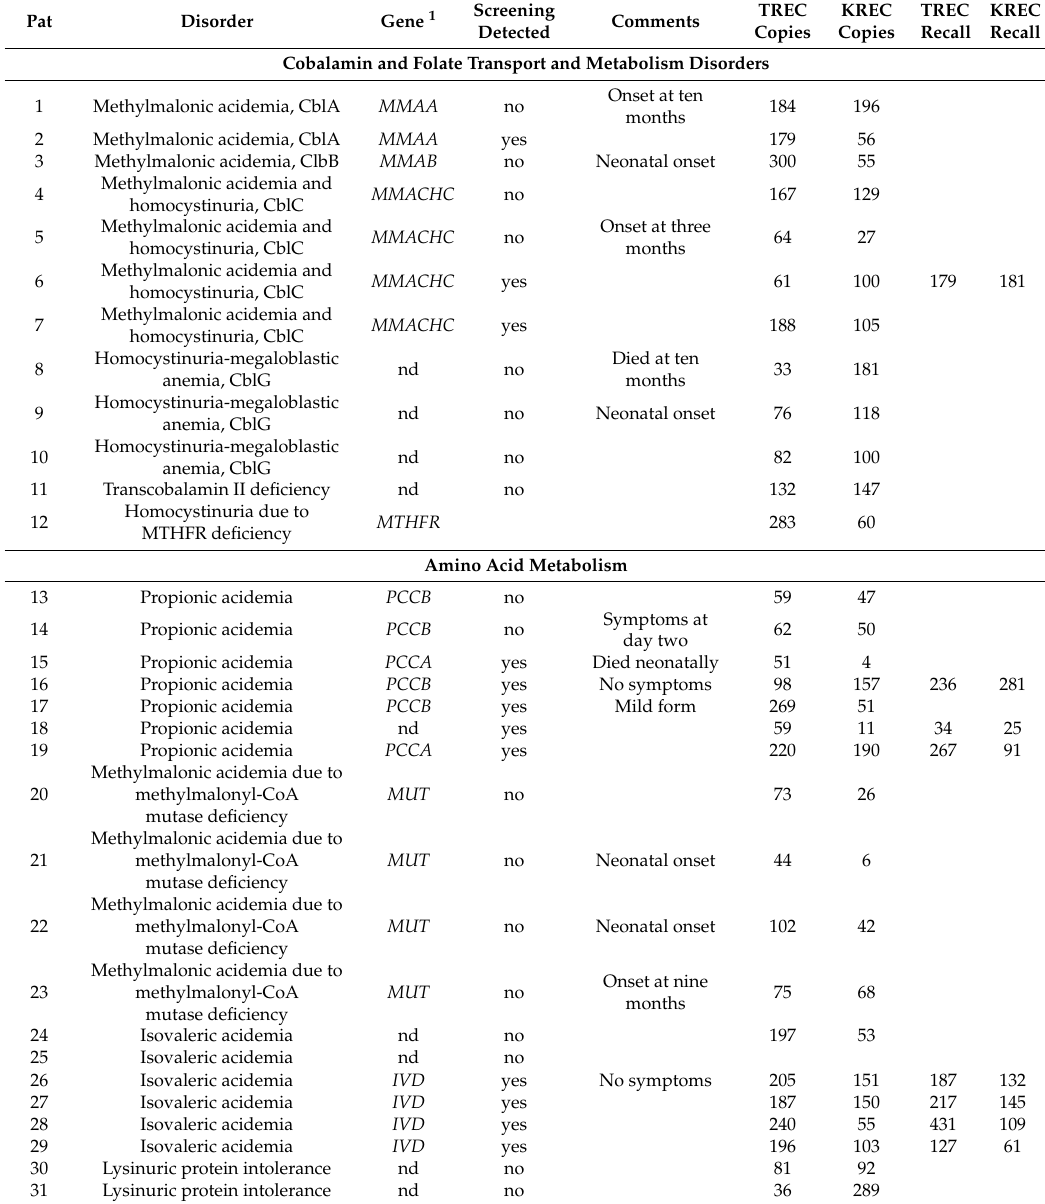
Table A1. Summary of results for patients with inborn errors of